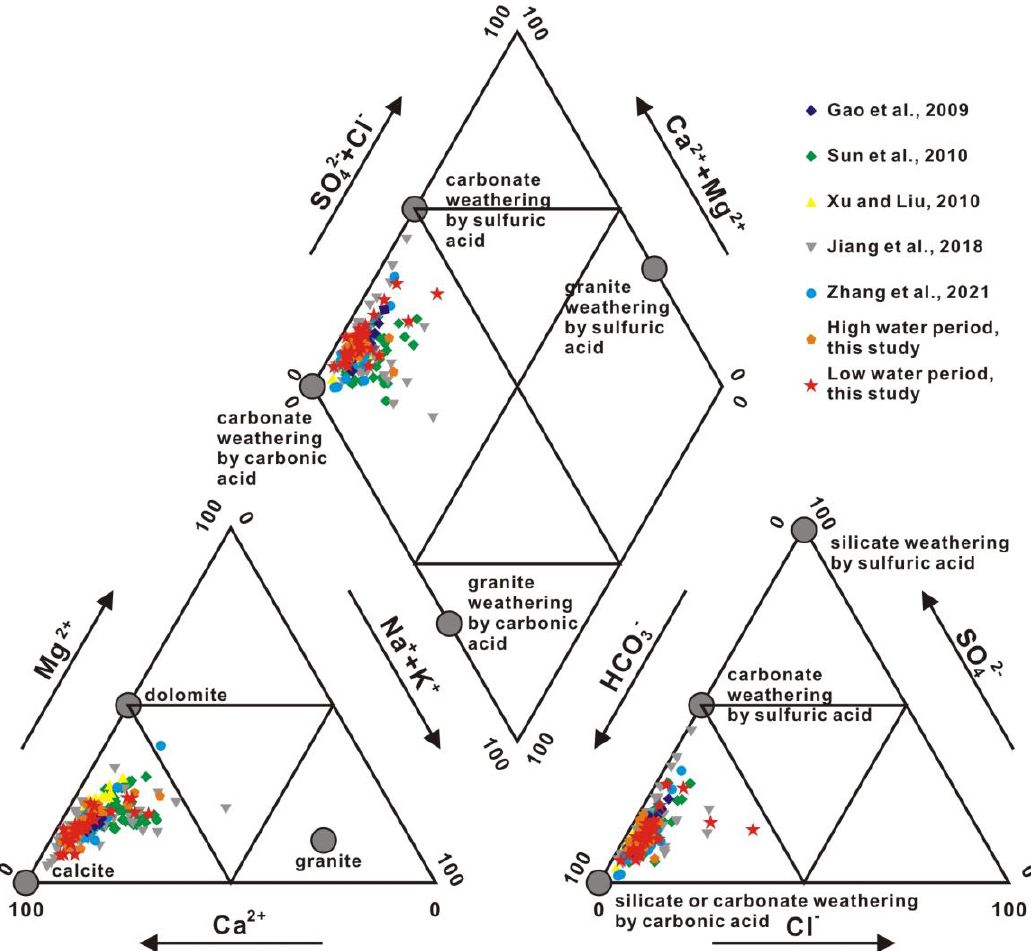
Figure 3. Piper diagram of the Xi River Basin with end-member compositions for carbonic and sulfuric acid weathering of major rock types [2,10,20,22,28].